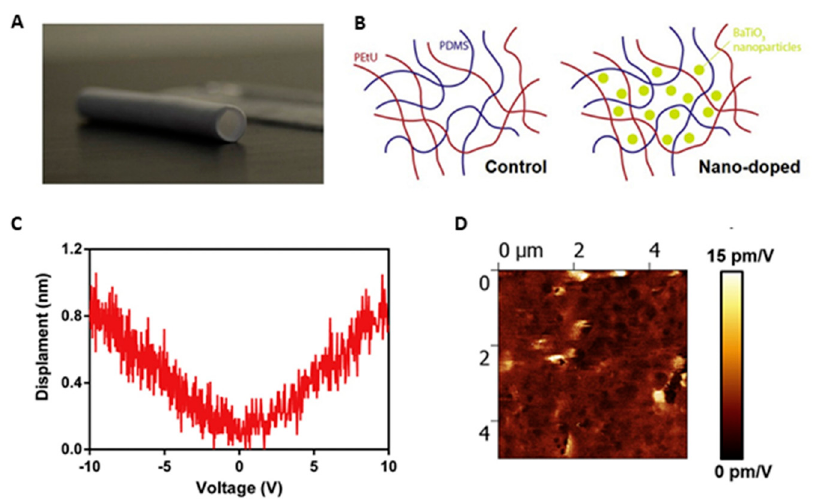
Figure 10. Piezoelectric small caliber vascular graft: ( A ) photograph; ( B ) schematic of the polymer network incorporating BaTiO 2 nanoparticles; ( C ) representative displacement-voltage curves, ob- tained for the nano-doped samples; and ( D ) piezoelectric force microscope images showing signal amplitude maps and corresponding average and maximum d 33 values for the nano-doped samples.